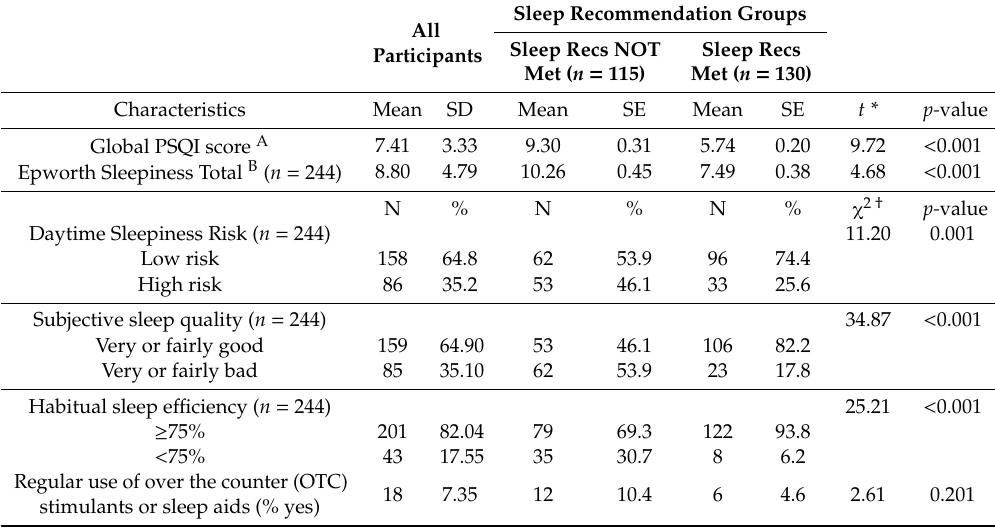
Table 2. Sleep behaviors by Canadian college student groups that met and did not meet sleep recommendations ( N = 245). Recs =